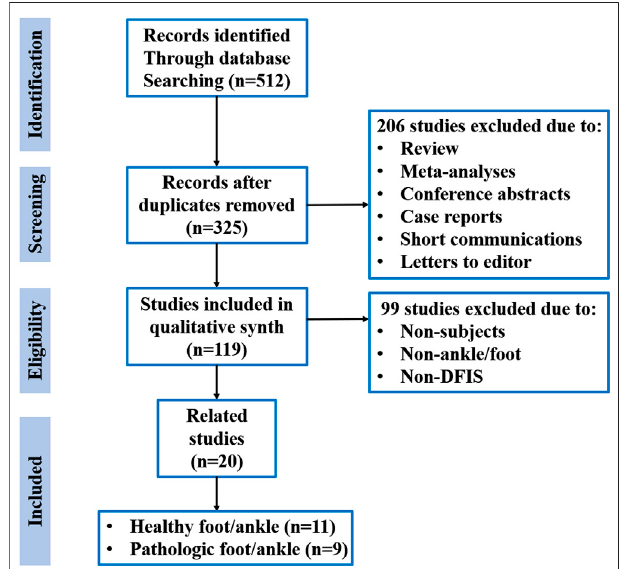
FIGURE 1 | Literature search and study